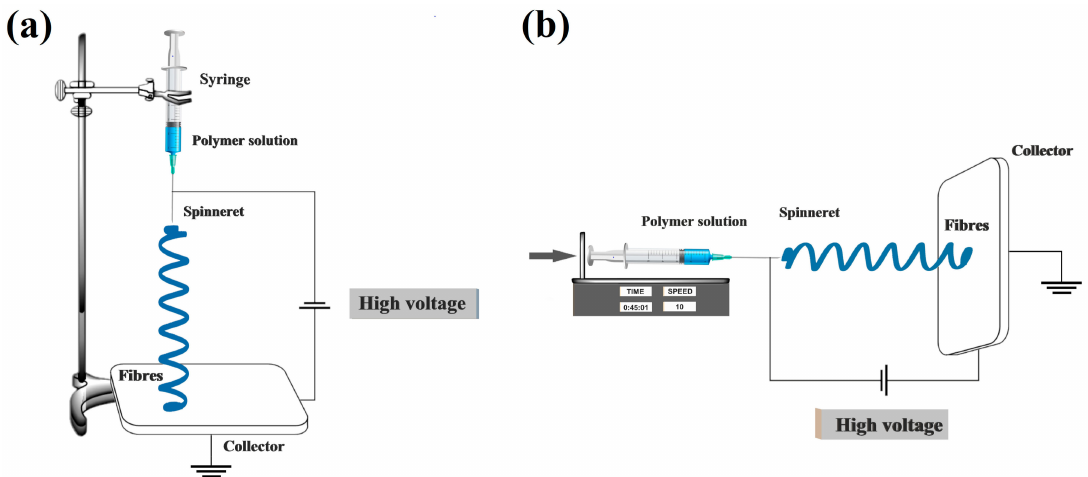
Figure 12. Schematic diagrams of ( a ) vertical and ( b ) horizontal electrospinning processes (created based on [219] with permission from Elsevier Publisher).